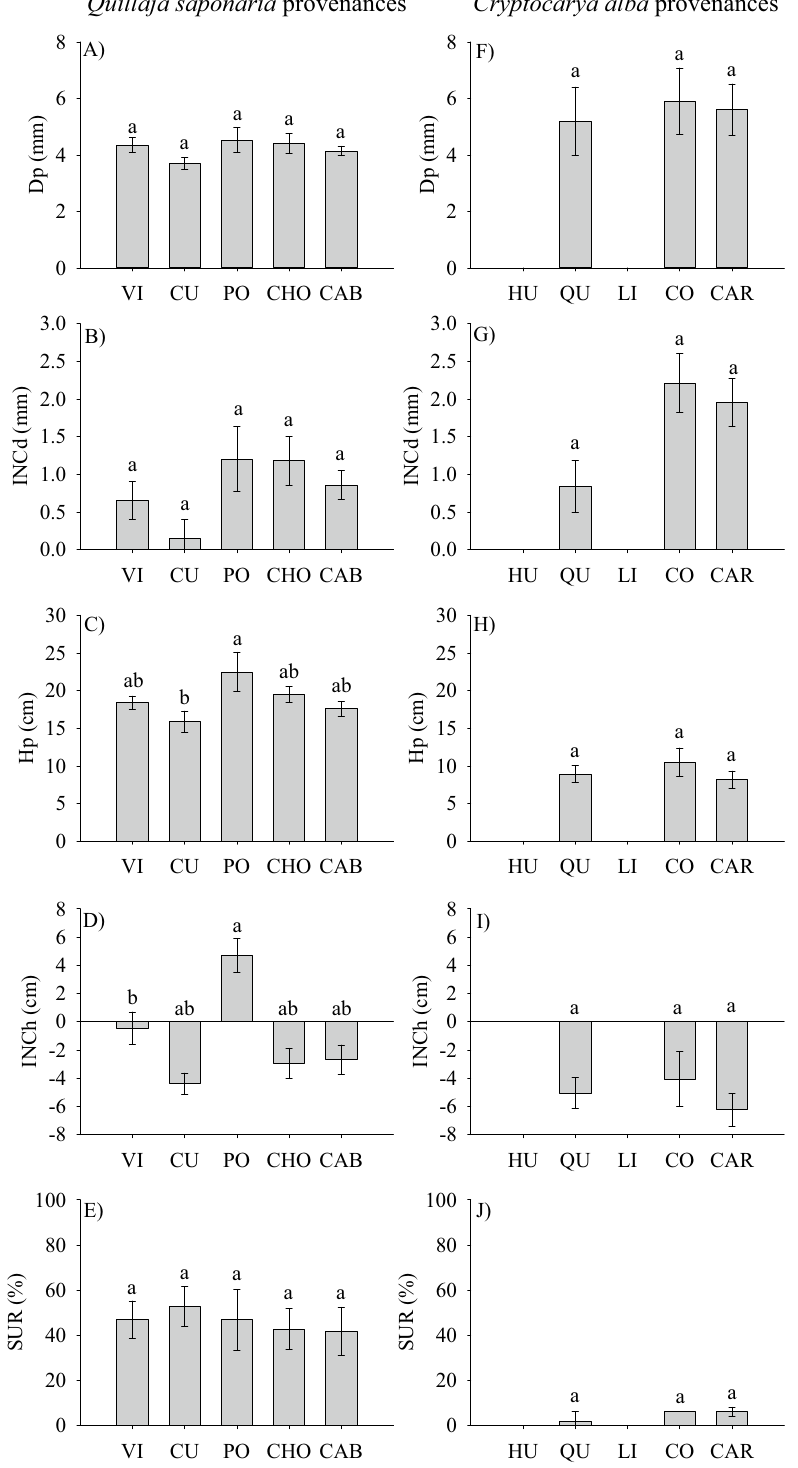
Figure 3. Survival ( SUR ), root collar diameter ( Dp ), height ( Hp ) and their respective increments in D ( INCd ) and H ( INCh ) for Q . saponaria and C . alba seedlings according to the provenance origin. Different letters indicate significant differences among provenances (Tukey test; p ≤ 0.05). The error bars indicate the standard error. Codes for provenances are according to Table 1. Provenances are ordered from left to right by latitude of